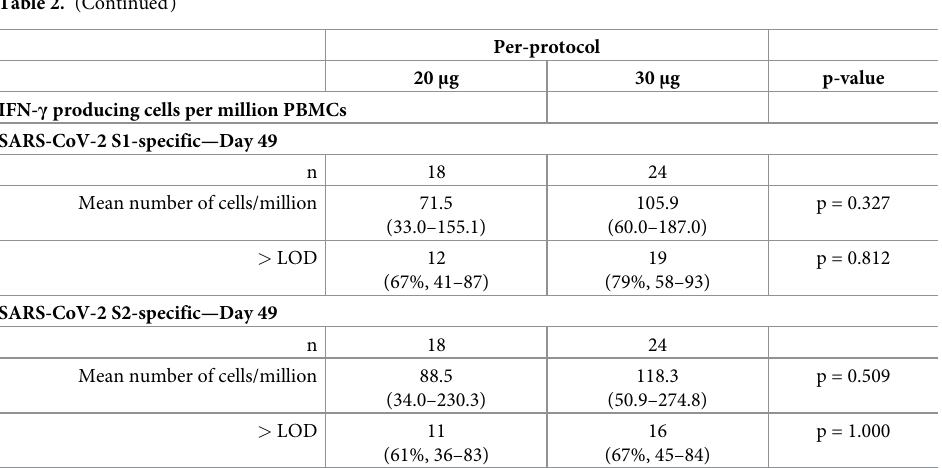
S2 = SARS-CoV-2 spike protein subunit